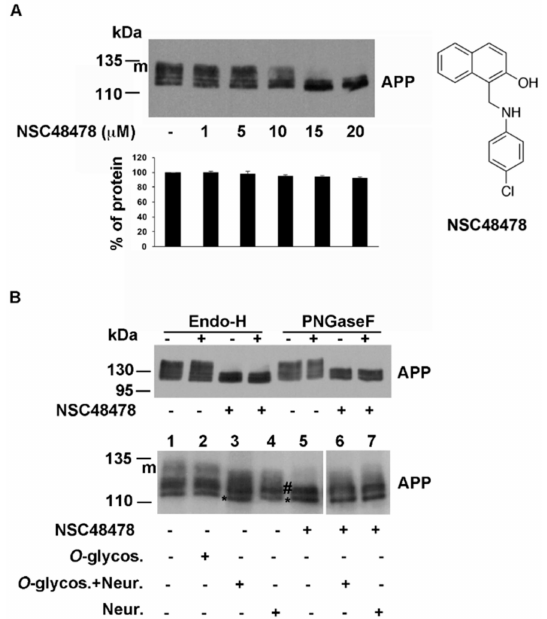
Figure 1. NSC48478 inhibitor a ff ects maturation of APP in neuronal cells. ( A ) GT1 cells grown in DMEM (Dulbecco’s modified Eagle medium) supplemented with 10% foetal bovine serum were scraped in lysis bu ff er and 40 µ g of total proteins were subjected to SDS-PAGE. APP was revealed by Western blotting on PVDF (Polyvinylidene Difluoride membranes) and hybridization with A8717 antibody. NSC48478 was used at di ff erent indicated concentrations for 24 h. Protein levels of APP were calculated by densitometric analysis with ImageJ software and expressed as percentage. The plot shows the percentage of APP after indicated concentration of NSC48478 treatment, using as 100% the experiments (* p < 0.05). ( B ) GT1 cells were either untreated or digested for 16 h with